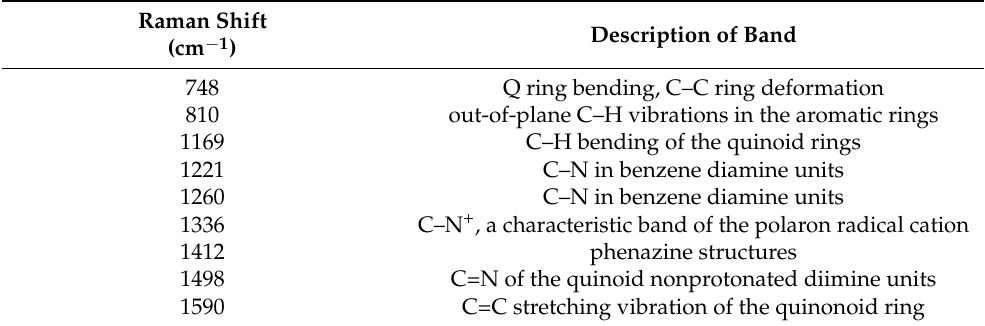
Table 1. Values of the average temperature coefficients of the sensitive polyaniline layers in a temperature range from 23 ◦ C to 80 ◦ C.